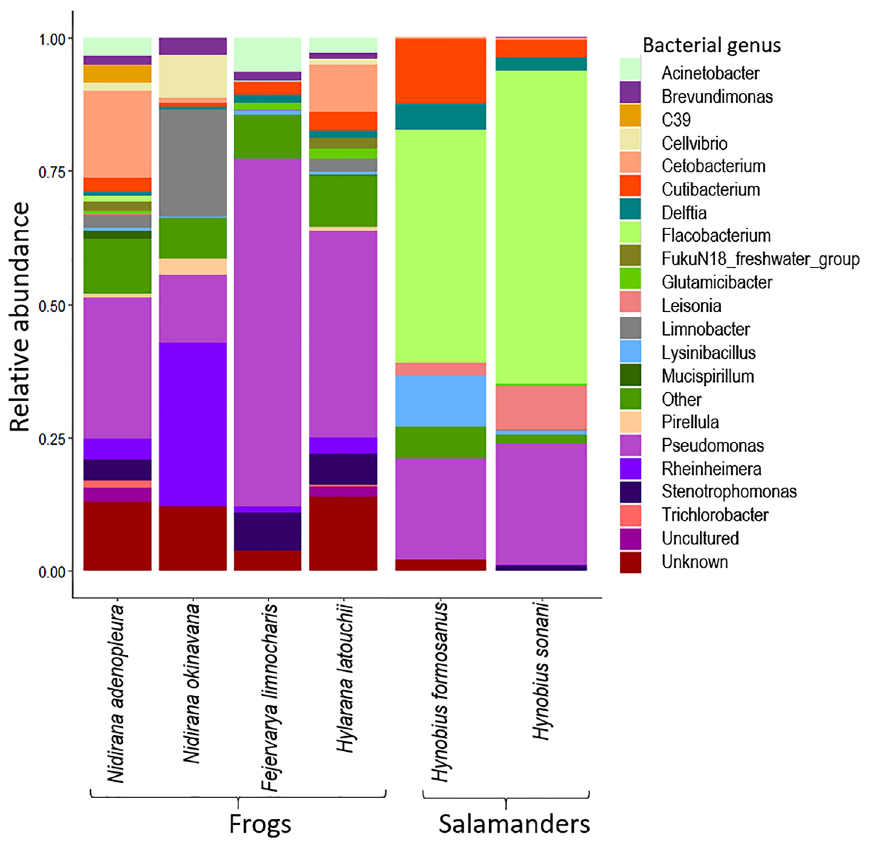
Figure 3. The skin microbial communities of the core bacterial genera occurring in at least 75% of individuals of four species of frogs and two species of